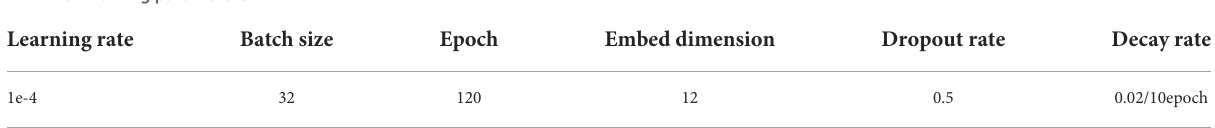
TABLE 3 Training